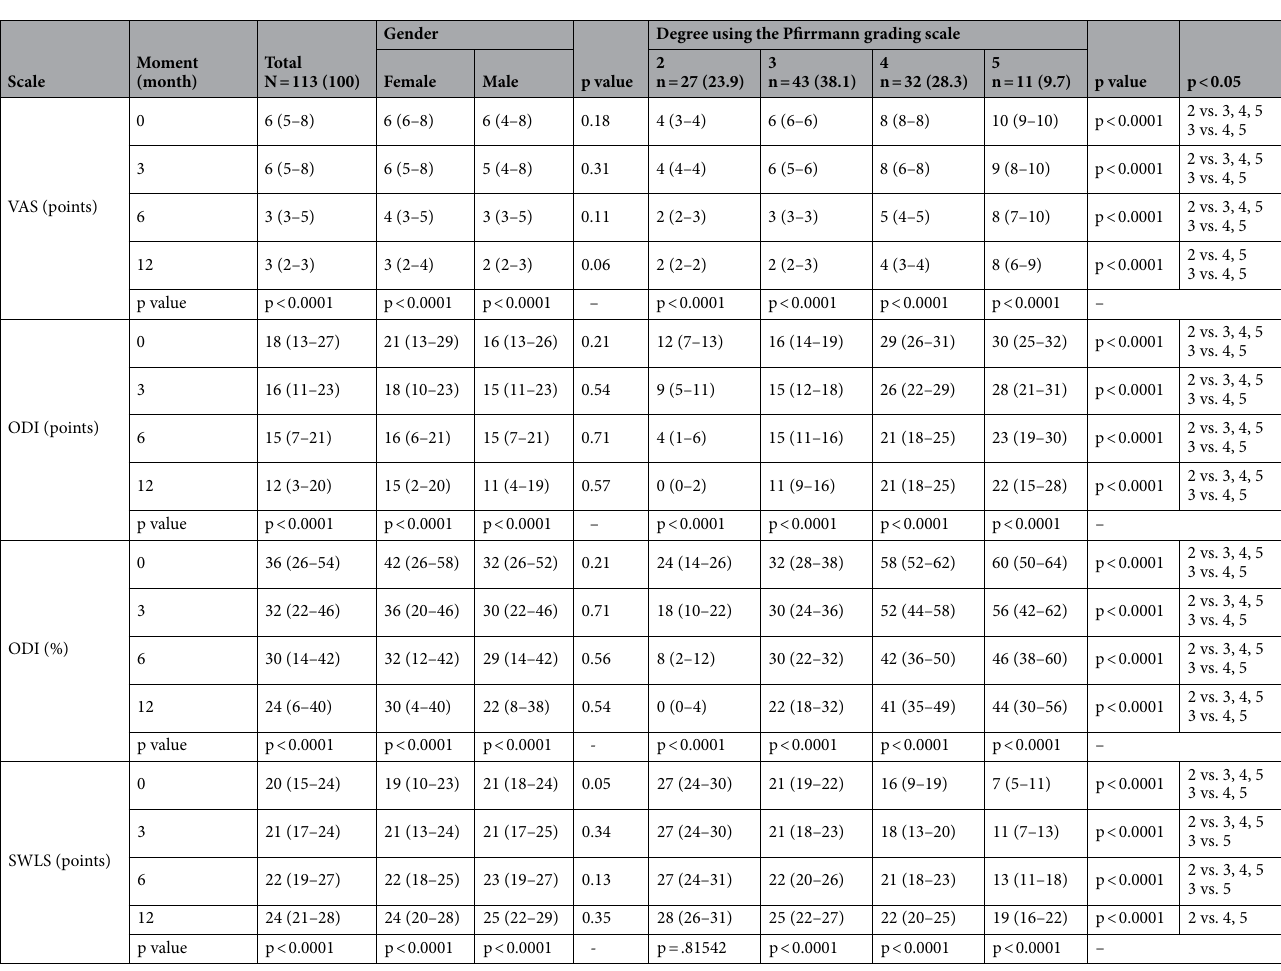
Table 2. Average assessment of pain intensity according to the VAS scale, degree of disability according to the ODI scale, and quality of life according to the SWLS scale of patients qualified for the microdiscectomy procedure, overall and divided for each radiological degree of advancement of degenerative changes according to the Pfirrmann scale. Quantitative data presented as median (1st quartile- 3rd quartile); p values by the Mann ‒ Whitney U test and the nonparametric ANOVA tests: the Friedman test for repeated measures, The Kruskal ‒ Wallis test.